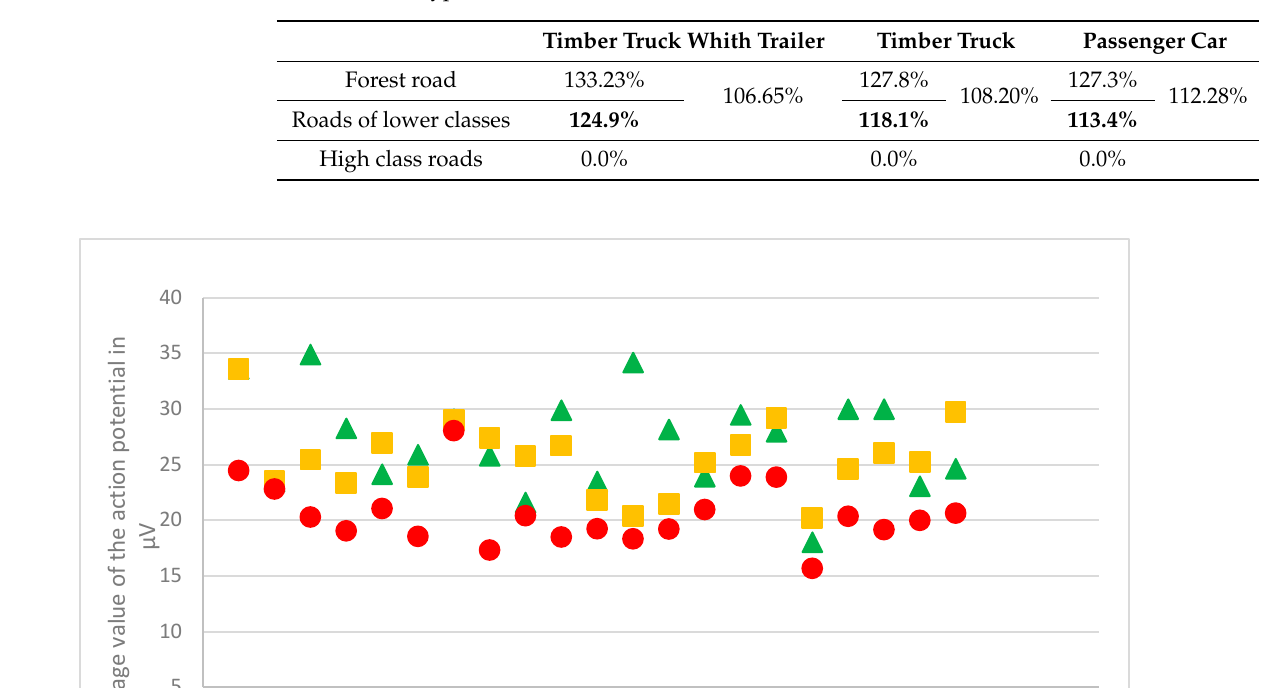
µ V of electric potential